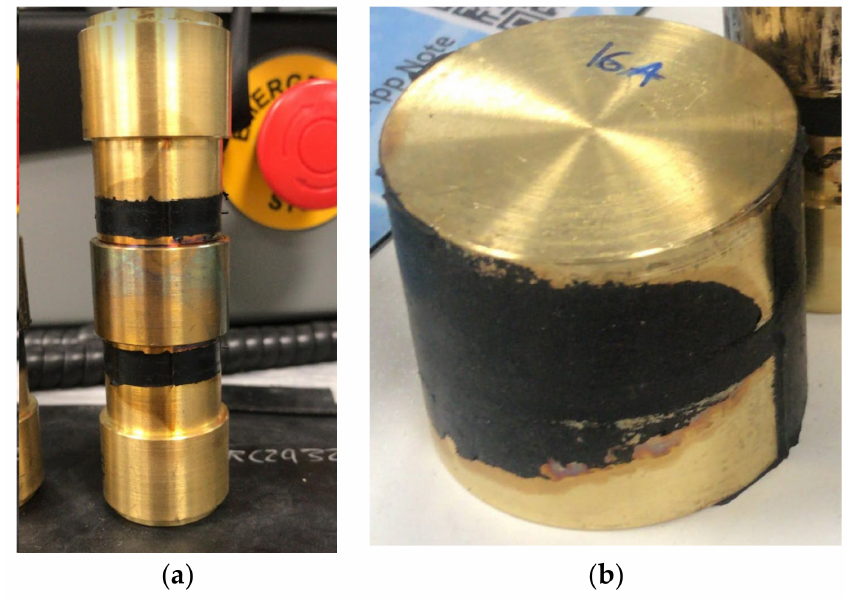
Figure 3. ( a ) DBS specimen, ( b ) Compressive